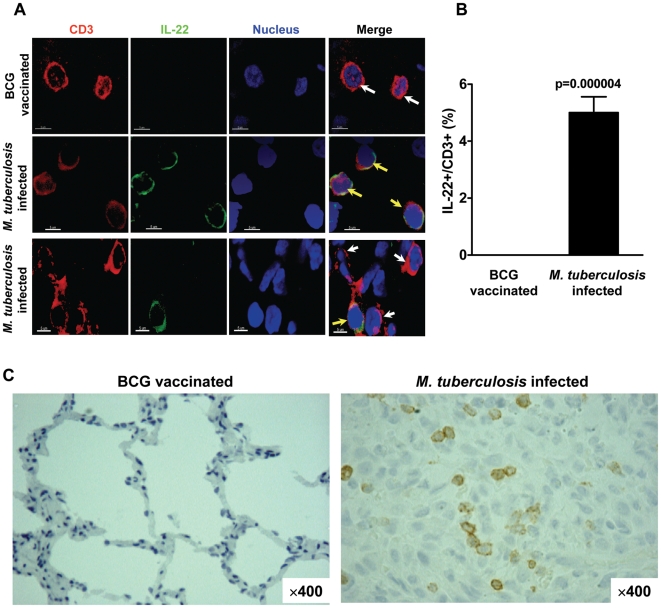
IL-22-producing T cells were detected in situ in lung TB granulomas from M. tuberculosis infected monkeys.(A) Representative confocal microscopic images (63× numerical aperture) at the middle and bottom panels show CD3+IL-22+ T cells (marked by yellow arrows) in lung tissue sections prepared from the right middle lung lobes at 8 weeks after M. tuberculosis infection in rhesus monkeys. The images at the top panel show that no IL-22 (white arrows) was detectable in CD3 T cells in the peri-bronchiolar lymphoid lung section derived from healthy macaques that received BCG vaccination 4 years before. Bar: 5 um. (B) Confocal imaging analyses show percentage numbers of IL-22-producing T cells in the CD3+ T cells in right middle and caudal lung lobe tissues from infected rhesus macaques and undetectable numbers of these cells in lung sections from healthy BCG-vaccinated macaques. Shown are mean percentage numbers in CD3+ T cells calculated from three M. tuberculosis-infected macaques and three healthy BCG vaccinated controls (see Methods). IL-22-producing T cells and IL-22 negative CD3+ T cells were counted from at least 20 confocal-section images in each of six different tissue sections from each macaque; the data from three macaques were then calculated for means, SEM, and p values. No IL-22 staining with very low background-level fluorescence was observed when using control isotype IgG and the antibody non-reactive with tissue-sectioning IL-22 (Data not shown). (C) Representative single-color immunohistochemistry imaging (x400) shows that IL-22-producing T cells (brown) were distributed in granuloma from the right caudle lung lobe (infection site) of one infected rhesus macaque (animal RH 7734, right). Similar staining data were seen in the lung sections from other M. tuberculosis-infected macaques. No IL-22-producing T cells were detectable in lung tissues from healthy BCG vaccinated rhesus macaques (representative animal RH 27097, left). RH (Chinese rhesus macaque).